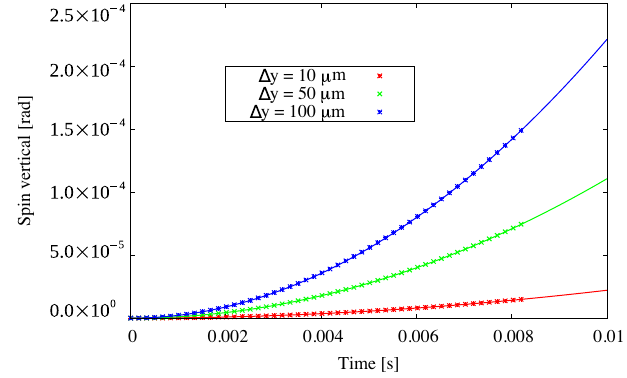
FIG. 4. Comparison of the tracking simulations with the analytical estimate (solid lines) for the case of one quadrupole misaligned vertically by Δ y ( Δ p=p ¼ 10 − 5